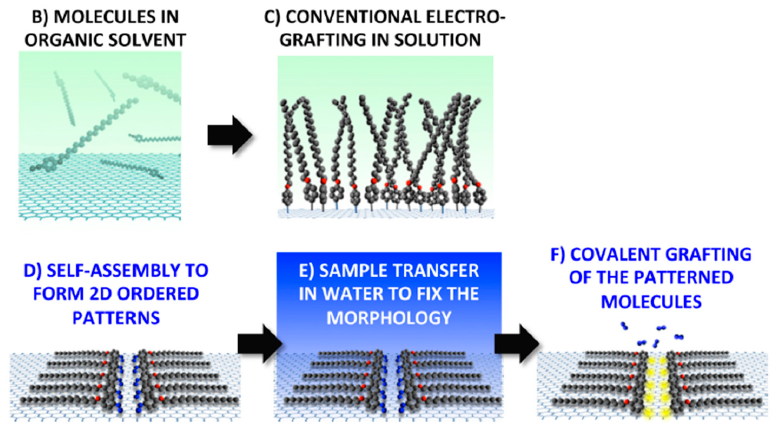
Figure 11. Adsorption and electrografting of long-chain benzenediazonium tetrafluoroborate on graphene. From Reference [63] with permission of the American Chemical Society.